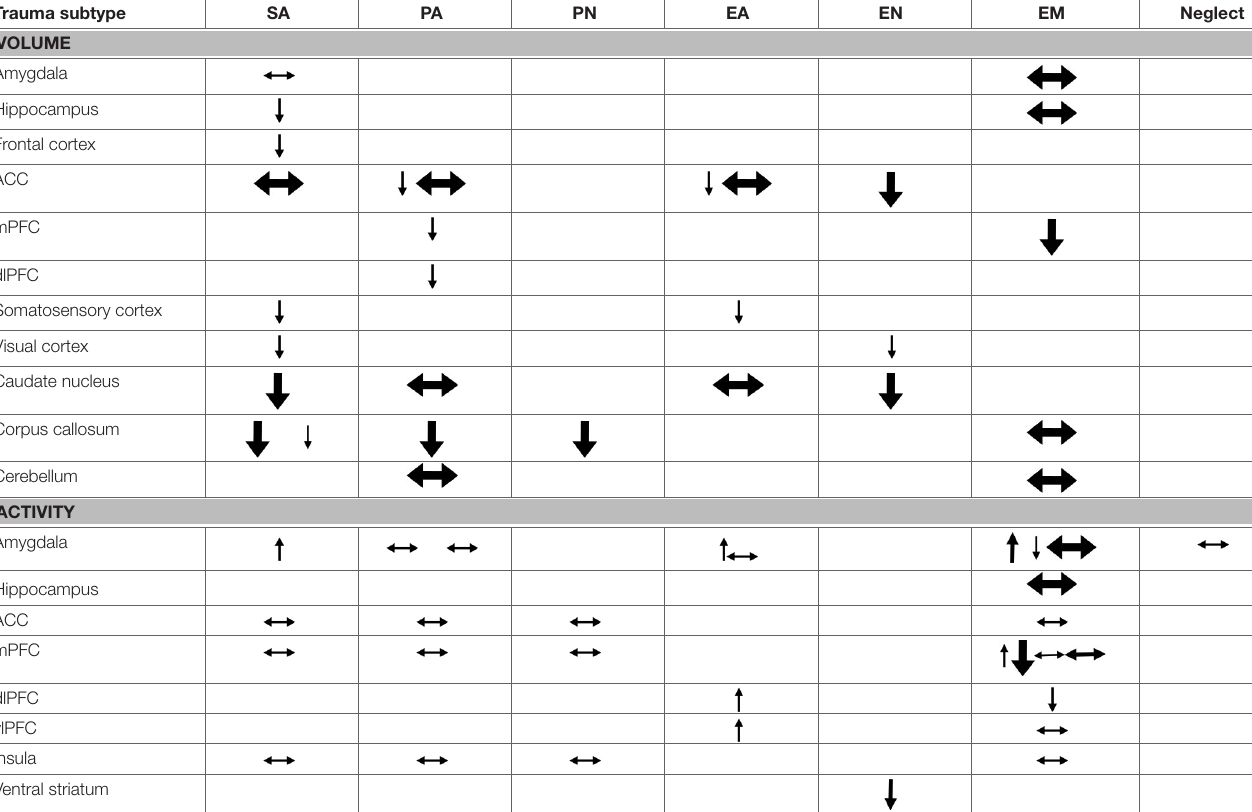
TABLE 3 | Structural and task-related functional comparison of trauma subtypes. Trauma